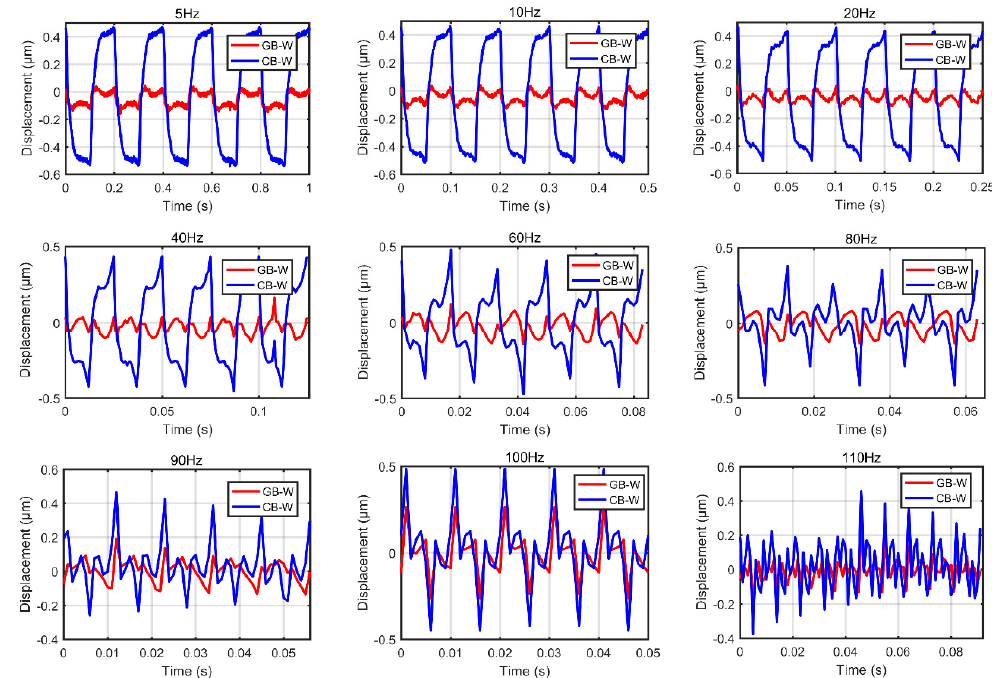
Figure 9. Rate-dependent modeling errors of the GB–W model and classical CB–W model.